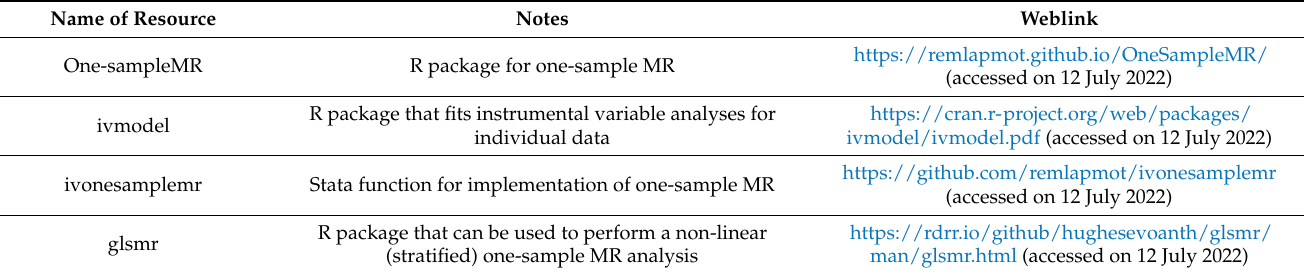
Table 2. Some selected useful statistical software resources for Mendelian